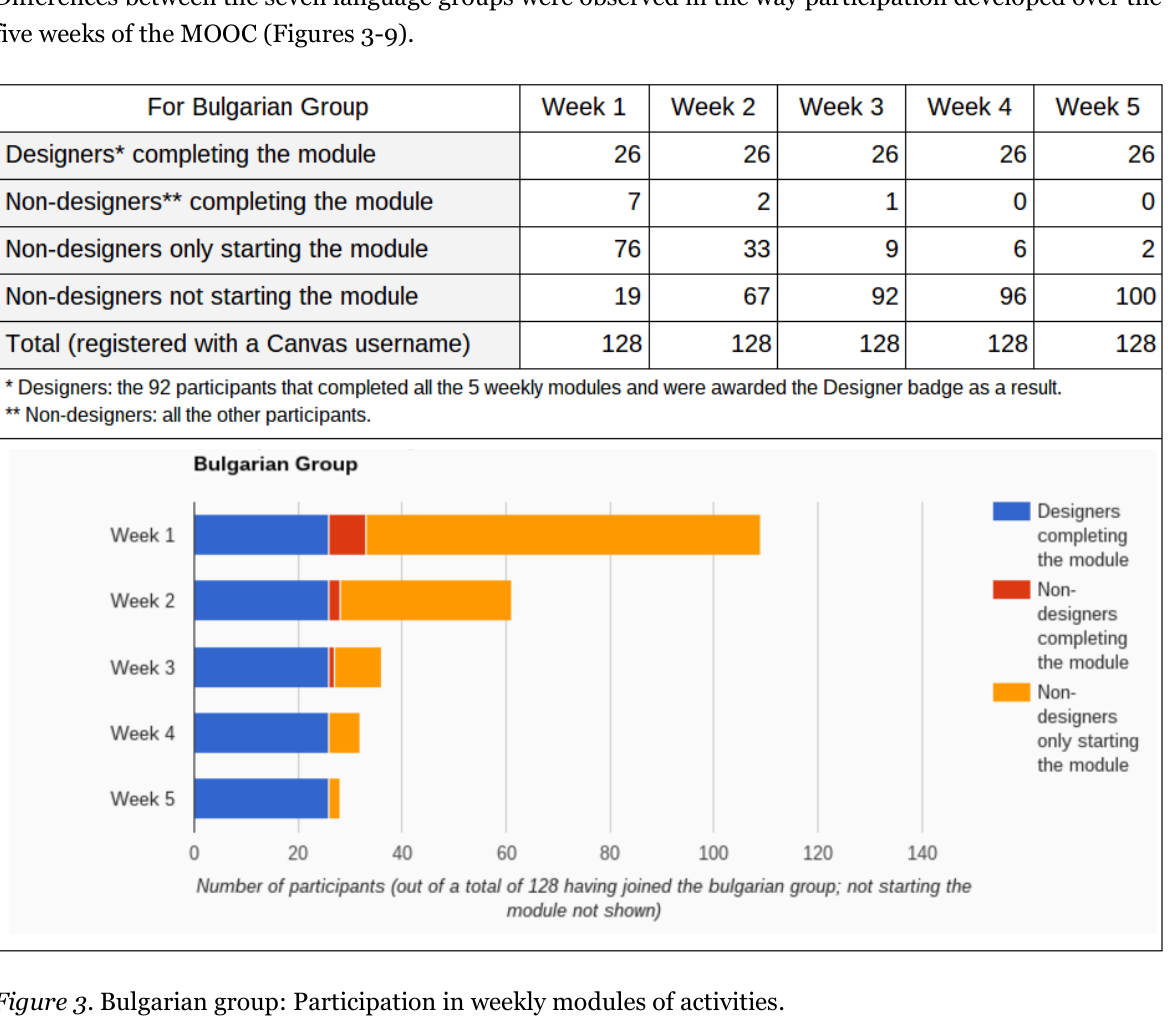
Figure 3 . Bulgarian group: Participation in weekly modules of